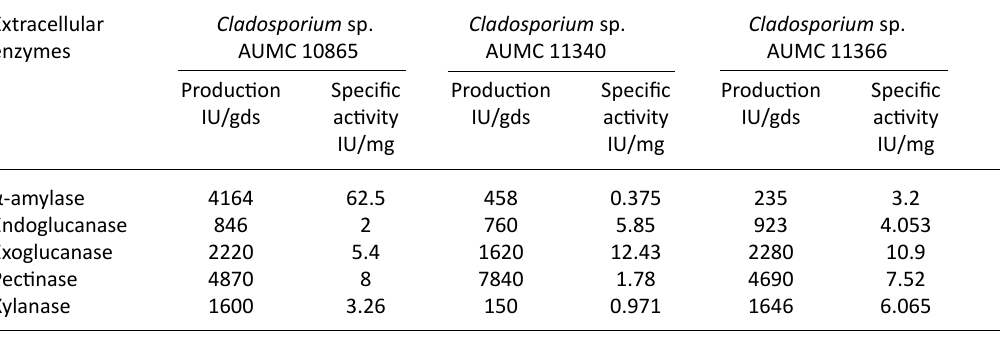
Table 1. Production and specific activity of amylase, endoglucanase, exoglucanase, pectinase and xylanase enzymes produced by Cladosporium isolates AUMC 10865, AUMC 11340 and AUMC 11366 in SmF at 10°C Extracellular Cladosporium sp. Cladosporium